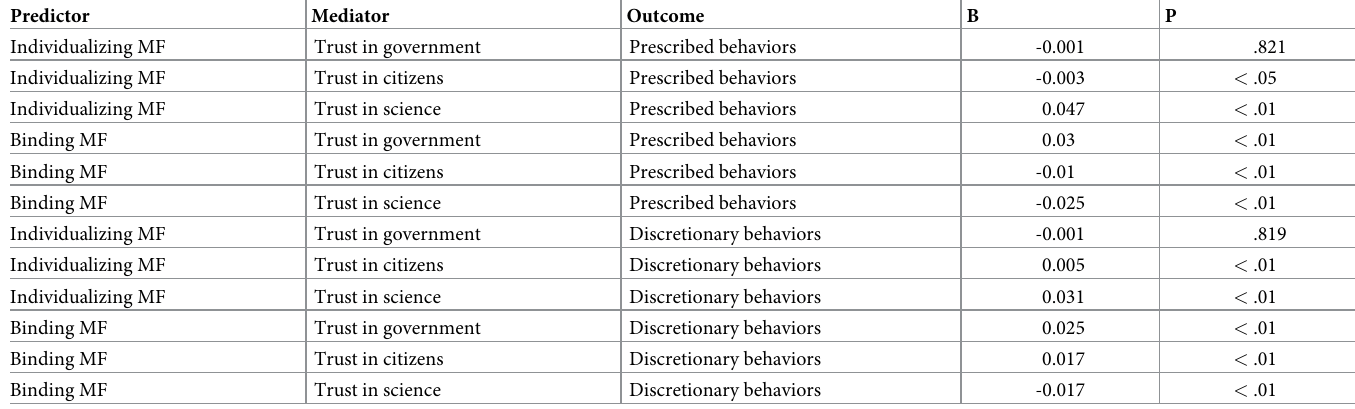
Table 2. Indirect effects of the model depicted in Fig 1 when controlling for both the individual and country level